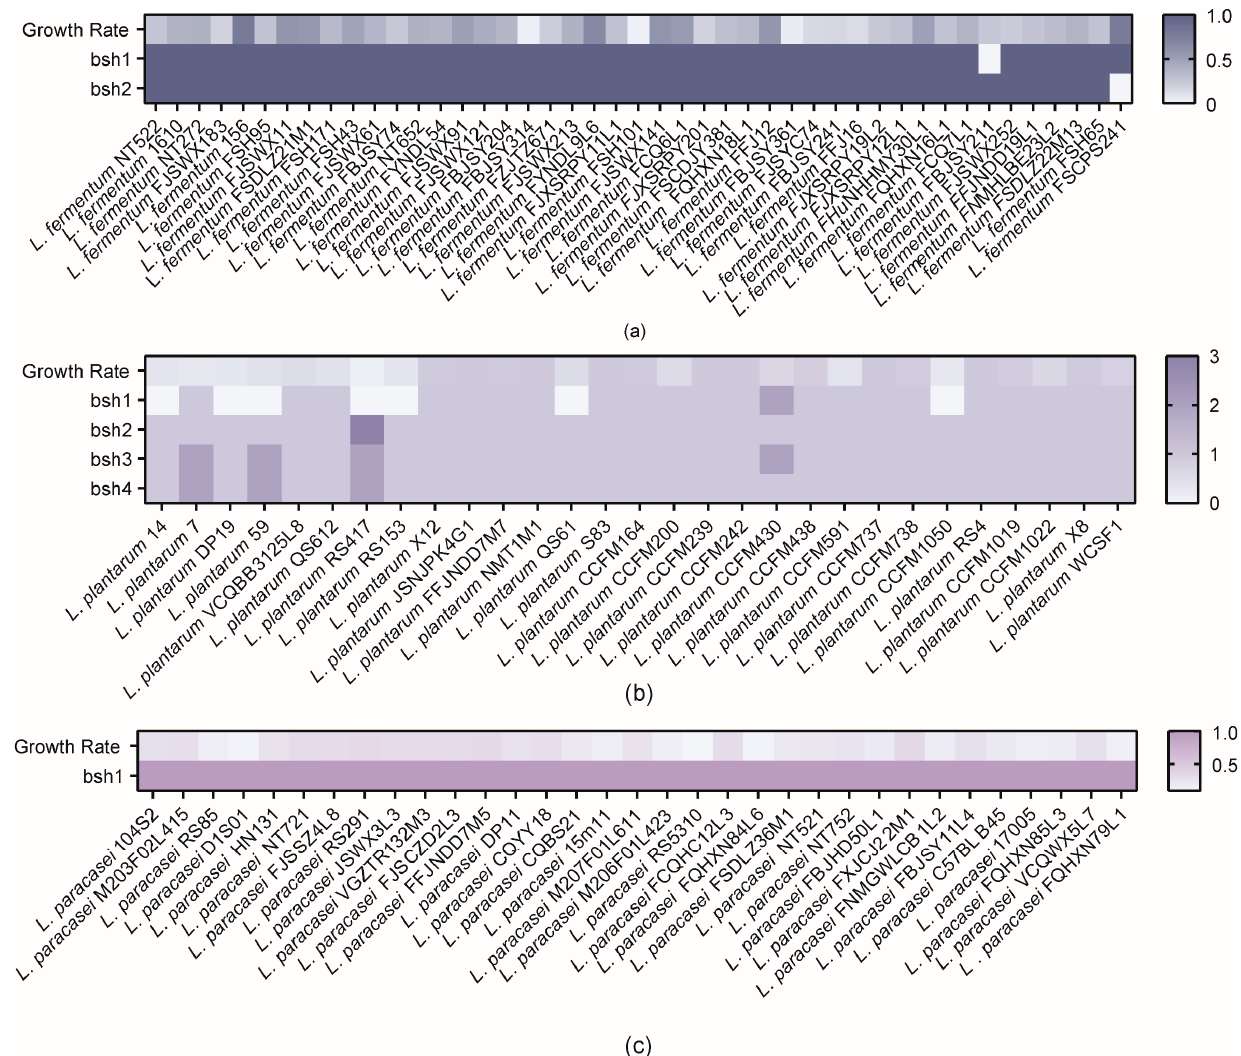
Figure 2. Heat map illustrating the distribution of BSH genes in lactobacilli and the growth rate of lactobacilli at 1.2% bile salt concentration. ( a ) L. fermentum , Spearman correction analysis, r = − 0.07473. ( b ) L. plantarum , Spearman correction analysis, r = 0.07870. ( c ) L. paracasei , Spearman correction analysis, r = 0.